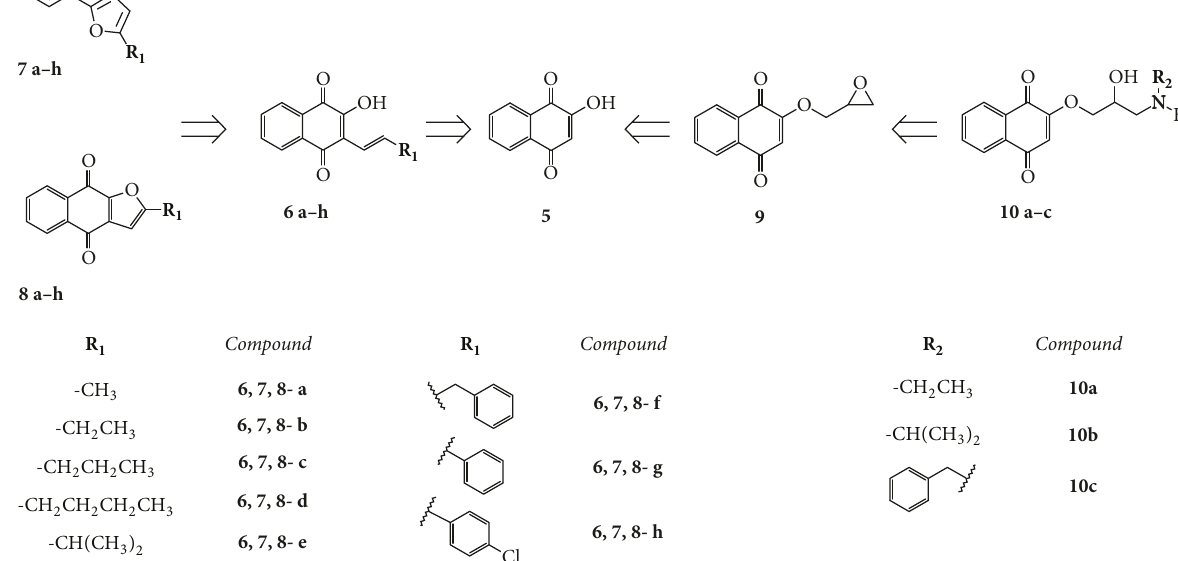
Figure 2: Retrosynthetic scheme of HNQs 6a–h , ortho- FNQ s 7a–h and para -FNQs 8a–h , 2-(oxiran-2-ylmethoxy)naphthalene-1,4-dione ( 9 ), and ANQs 10a–c, starting from lawsone ( 5